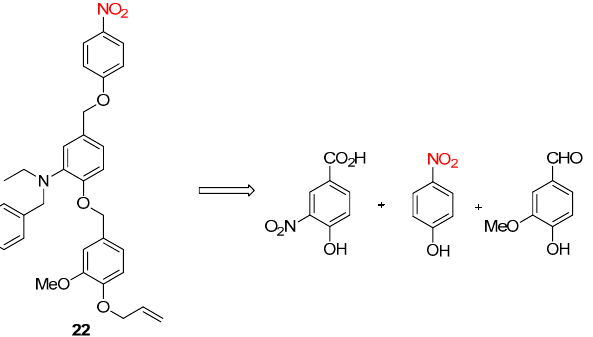
Figure 3. Dendrimer 21 resulting in dendritic amplification.